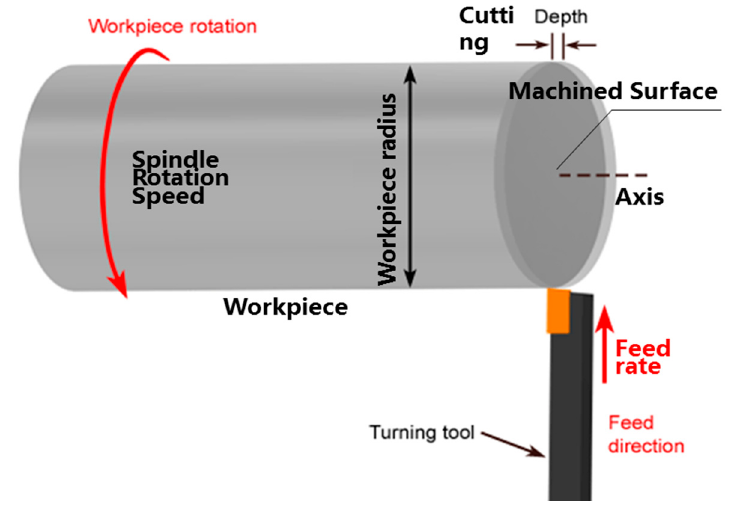
Figure 3. Processing principle of single point diamond turning (SPDT).